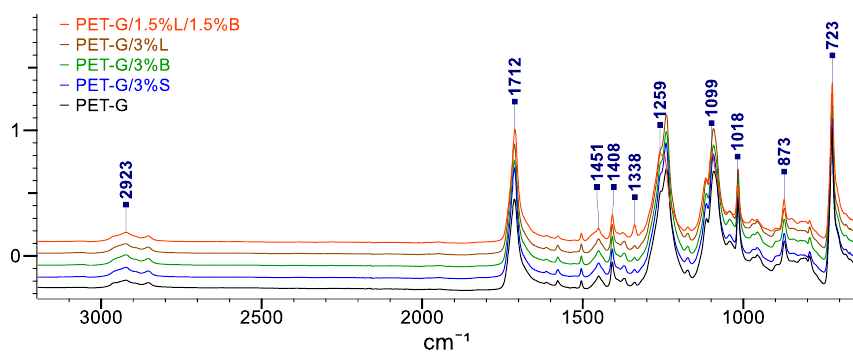
Figure 11. FT-IR spectra recorded for the